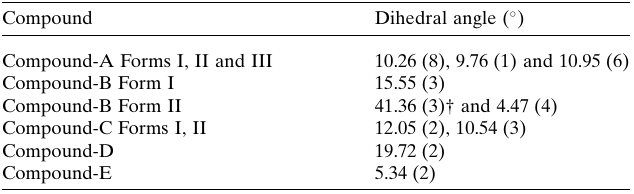
Table 2 Dihedral angles between the two rings C1–C6 and C9–C13/N3. Compound Dihedral angle ( (cid:3) ) Compound-A Forms I, II and III